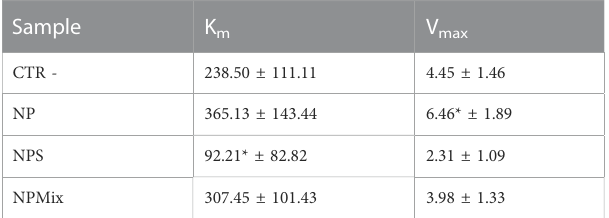
TABLE 5 K m and V max results for the enzyme tyrosinase. Data are reported as mean values ± LSD. * p < 0.001 compared to CTR -.